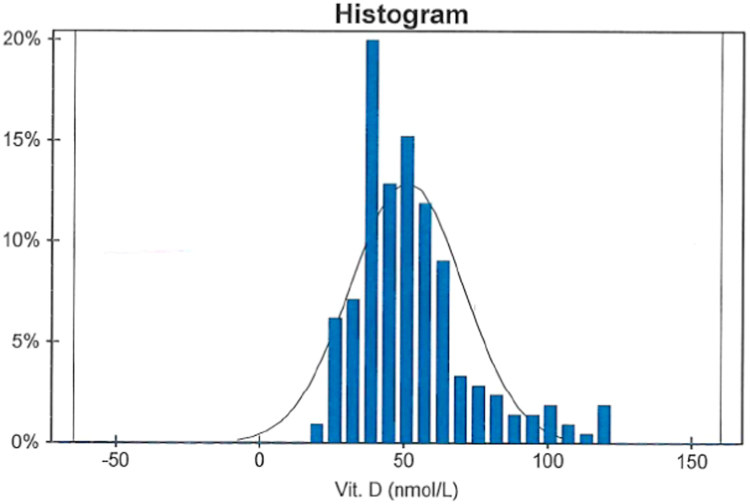
Reference interval data and distribution for 25OHD concentrations measured with the old generation of Abbott reagents (3L52). Results are from 210 healthy volunteers who provided serum samples for the study. No significant difference was observed in sex or age. All adults were Irish Caucasian. Distribution shows the non-Gaussian trend in the data, and median total 25OHD value for all subjects was 49 nmol/L.